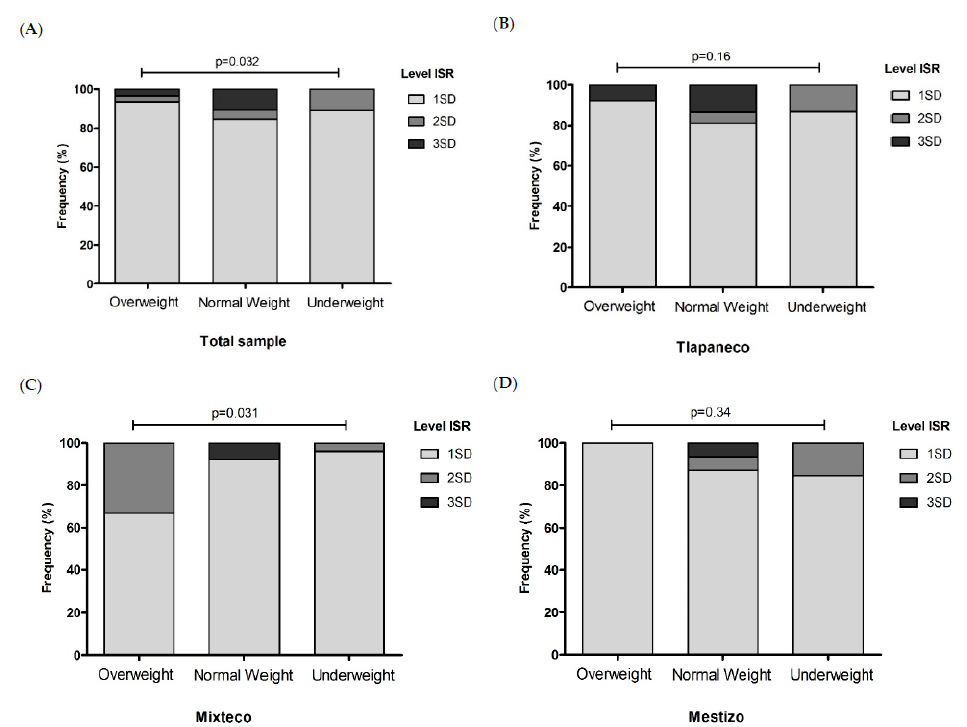
Figure 3. Distribution of positive cases to measles antibodies according to standard deviation (SD) levels of index standard ratio (ISR), considering the weight category. ( A ) Distribution in the total sample. ( B ) Distribution in the Tlapaneco group. ( C ) Distribution in the Mixteco group. ( D ) Distribution in the Mestizo group. Data is reported as n (%). Chi-square test. Significance value at p <